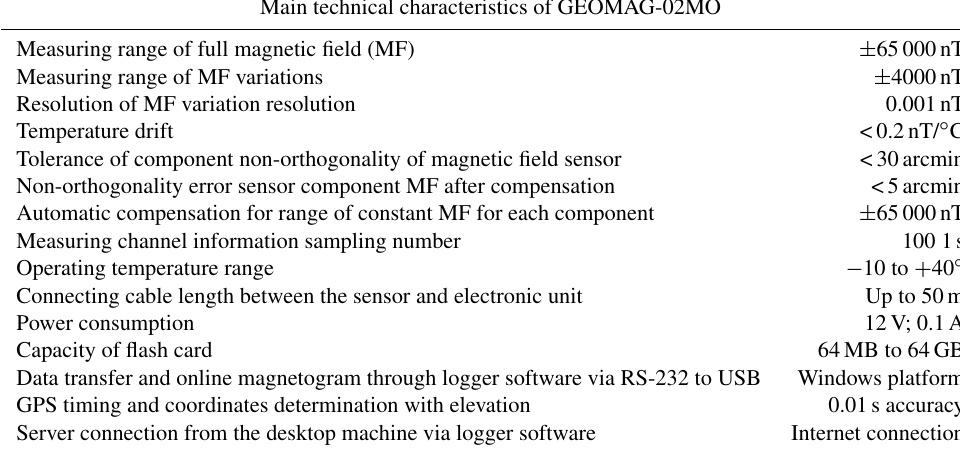
Table 1. Technical specifications of